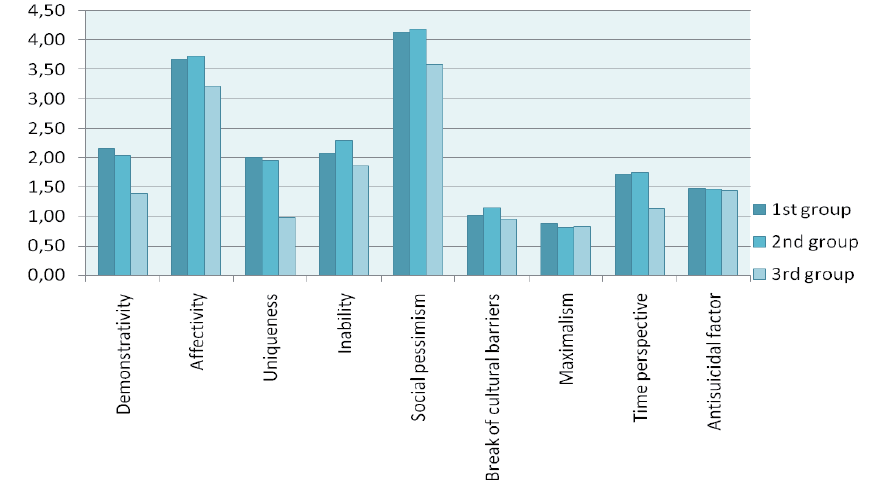
Source: Author. Fig. 2. Comparison of suicidal risk indicators in three groups under research